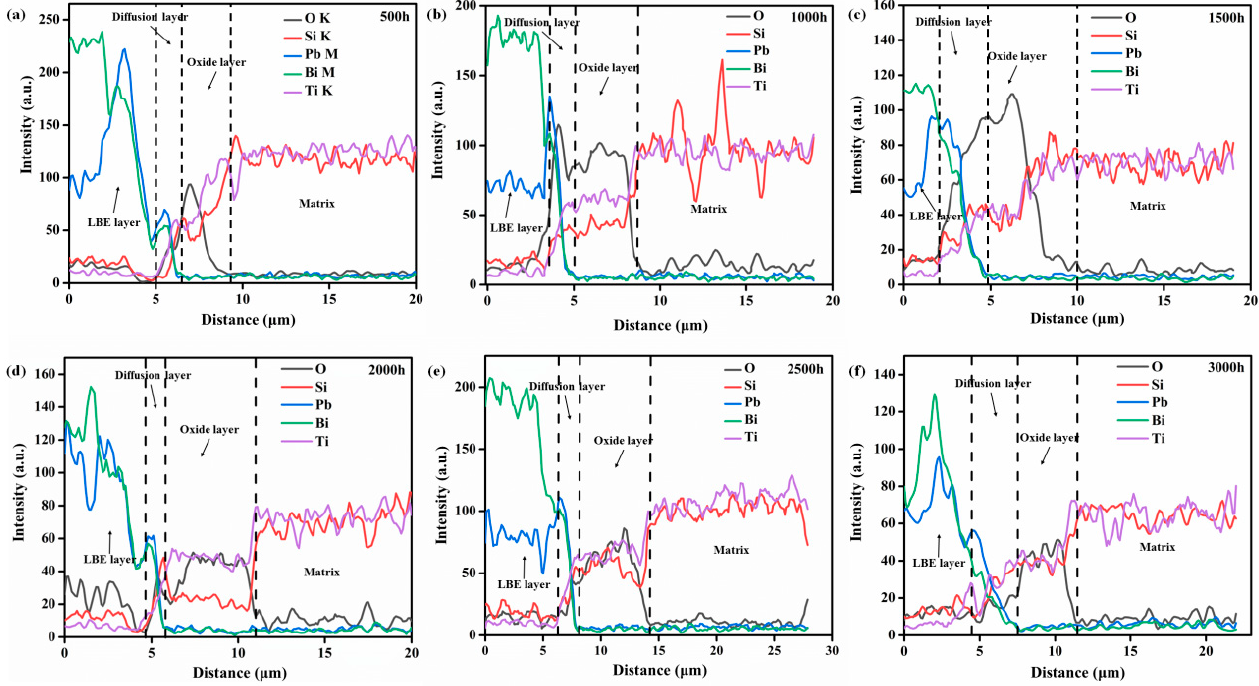
Figure 4. EDX line scan of cross-section of Ti 3 SiC 2 after LBE corrosion for 500 h to 3000 h ( a – f